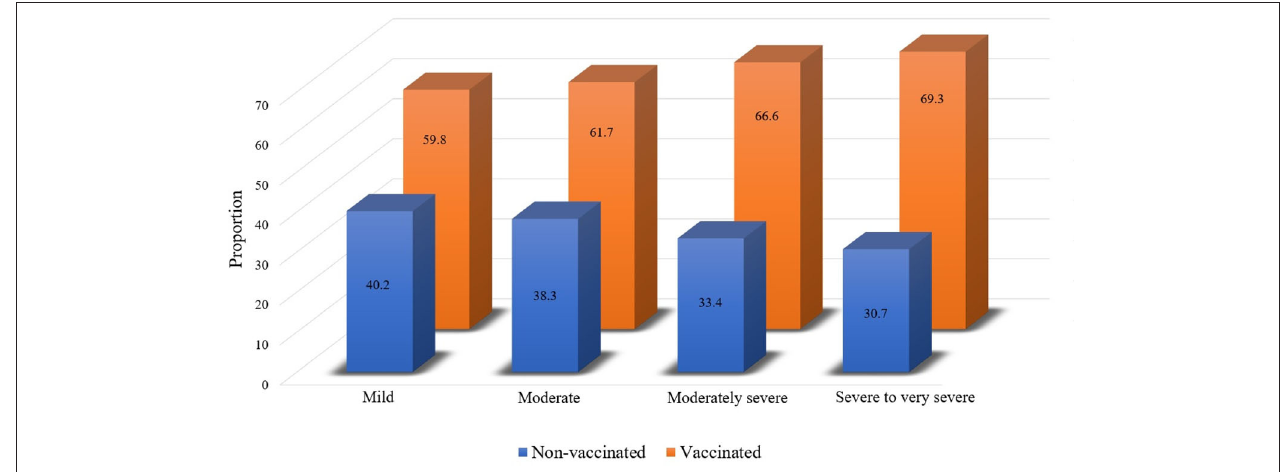
FIGURE 4 | Influenza vaccination rate according to AFL severity. AFL, airflow limitation.